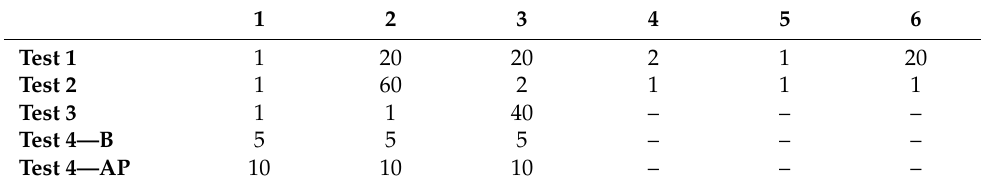
Table 12. Punches not exceeding the minimum number of